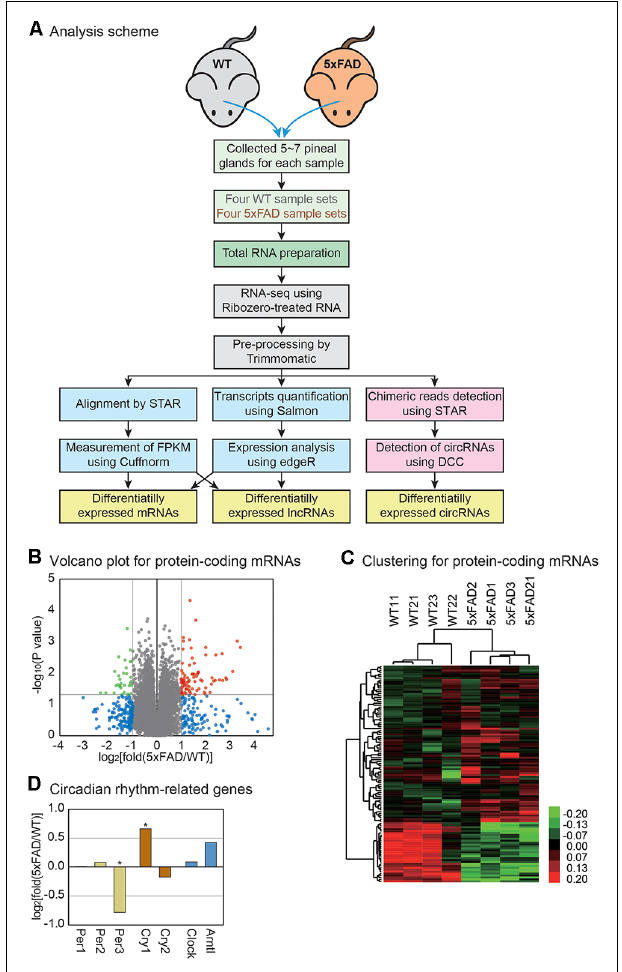
FIGURE 1 | Transcriptome analysis of the mouse pineal gland with Alzheimer’s disease (AD). (A) Analysis scheme. The pineal glands were separated from the wild type and 5xFAD mice, and total RNAs were extracted for RNA sequencing analysis. The sequencing data were analyzed by two different pipelines, STAR-Cuffnorm and Salmon-edgeR, to identify differentially expressed mRNAs and lncRNAs. To quantify the circRNAs, chimeric reads were detected by STAR and circRNAs were measured by DCC. See the “Materials and Methods” section for details. (B) Volcano plot for protein-coding mRNAs. Those genes with P -value < 0.05 and those with a change greater than 2-fold are indicated by colored dots. (C) Clustering for protein-encoding mRNAs. For the selected genes from (B) , unsupervised hierarchical clustering was performed. The color bar represents the expression differences between the wild type and 5xFAD samples. Note that each group clustered together properly. (D) The expression level change of genes related to the circadian rhythm. P -value was calculated using a one-tailed t -test ( ∗ <